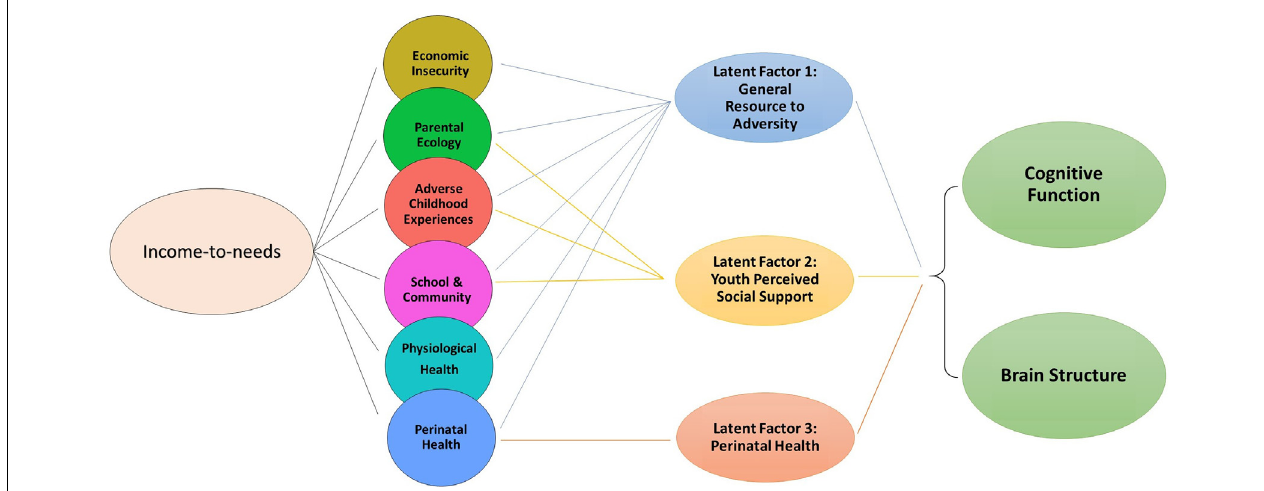
FIGURE 3 | Conceptual model showing that while the INR is associated with proximal measures across ecologies of economic, psychosocial, physiological, and perinatal well-being, three latent factors were derived from the proximal measures to examine associations between each latent factor and cognition scores and total cortical surface area, beyond the INR.